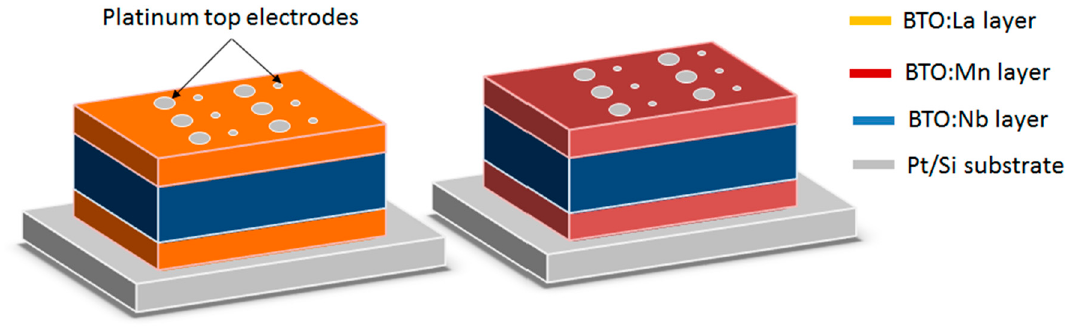
Figure 1. Multilayer structures with Pt top electrodes for electric measurements. Left: LNL10. Right: MNM20.